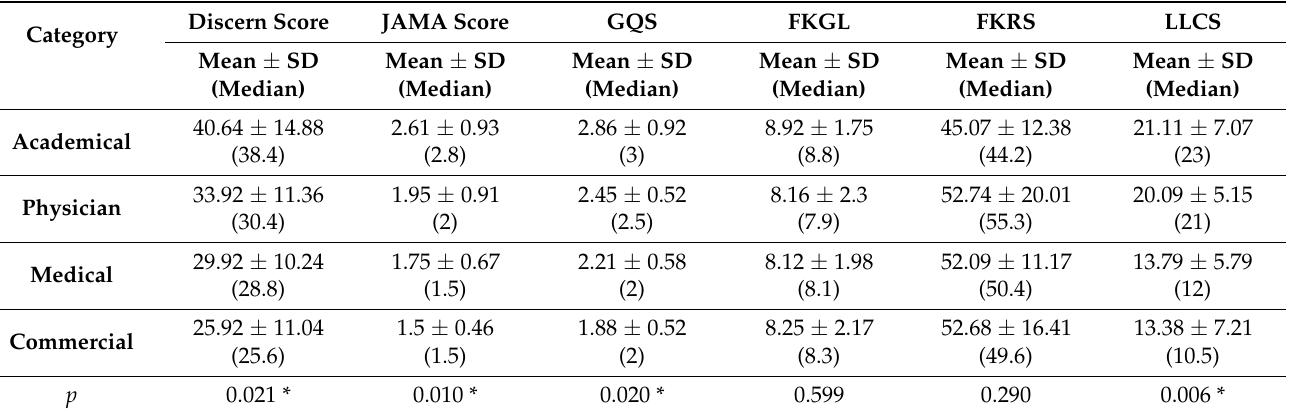
Table 3. Evaluation categorical